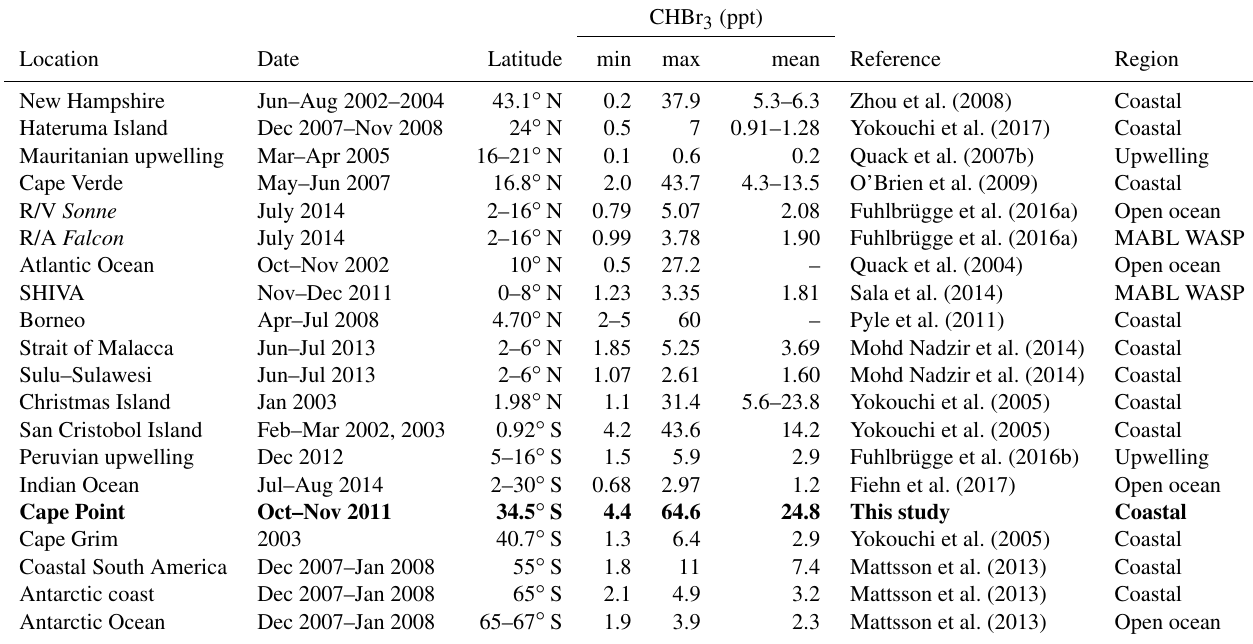
Table 1. Selected comparison measurements of bromoform in air samples above coastal, upwelling, open-ocean, and lower marine boundary layer regions. Tidal height is given in metres above the standard datum.